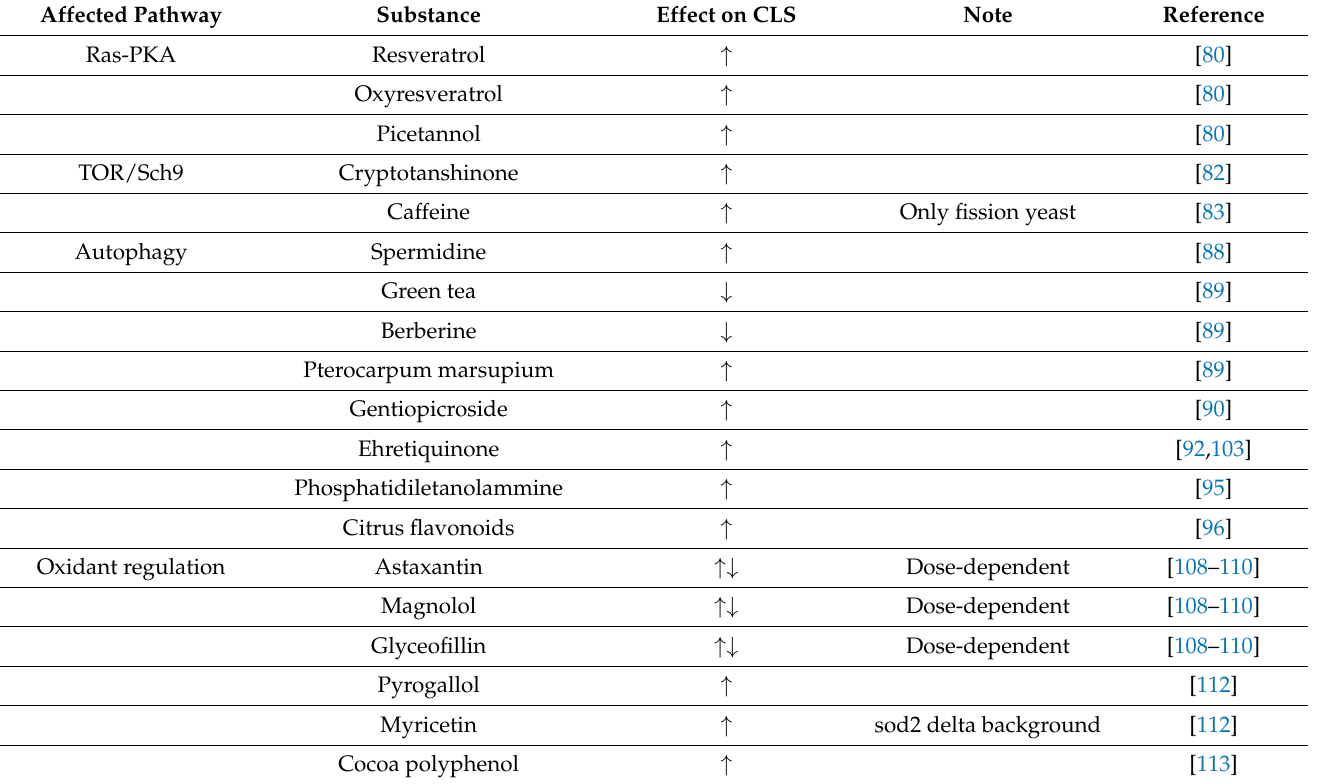
Table 1. Natural substances affecting yeast longevity and mechanisms